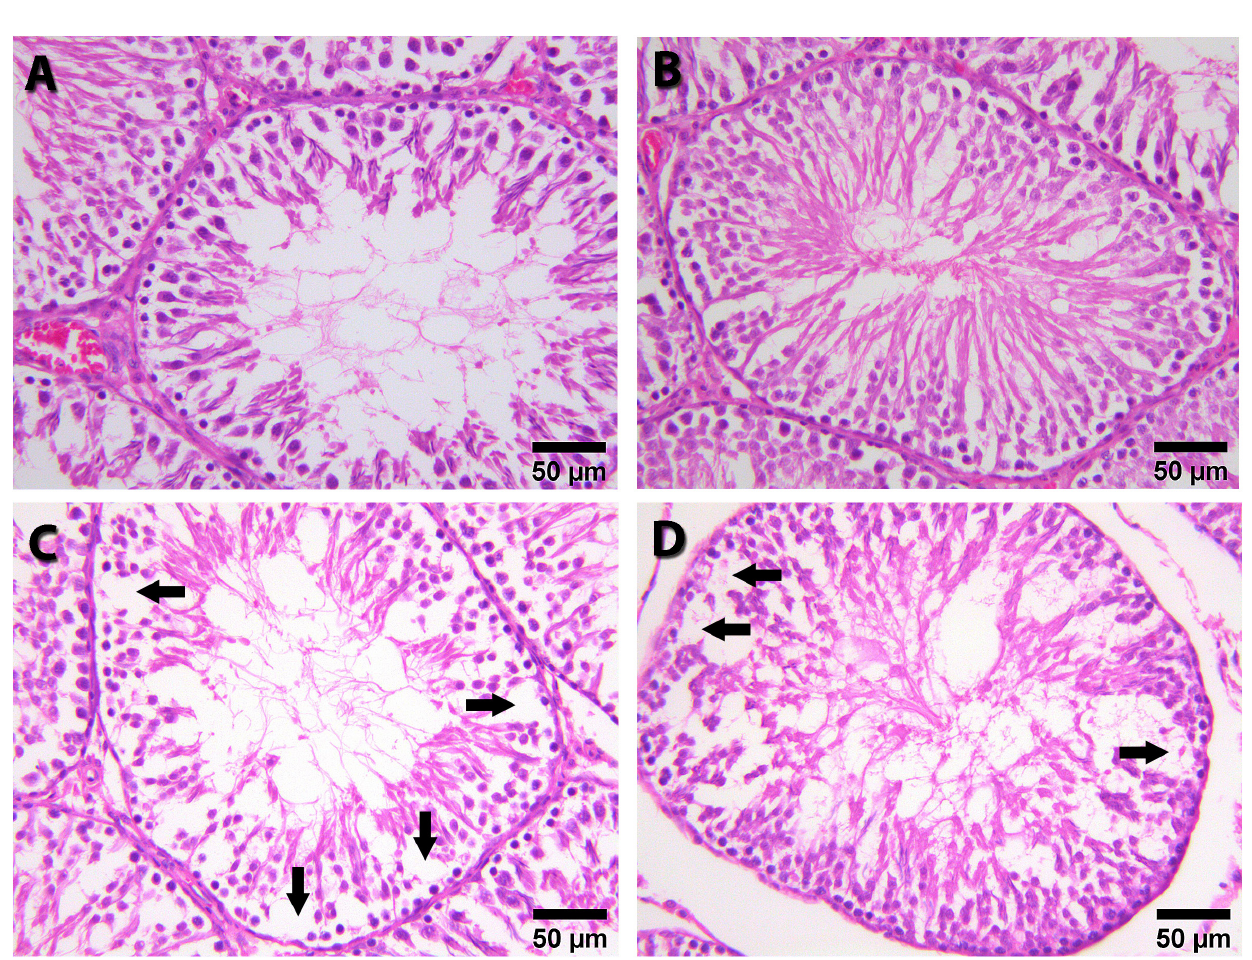
FIGURE 3 - Morphological appearance of testicular tissue obtained from different experimental groups, HE staining (x200 magnification). (A) and (B) - Normal testicular tissue with preserved seminiferous tubule structure and a normal number of sperms within the lumen observed in group I and II, respectively; (C) and (D) – Mild disturbance in seminiferous tubule structure with occasional loss of germ cells (arrow) seen in group III and IV,